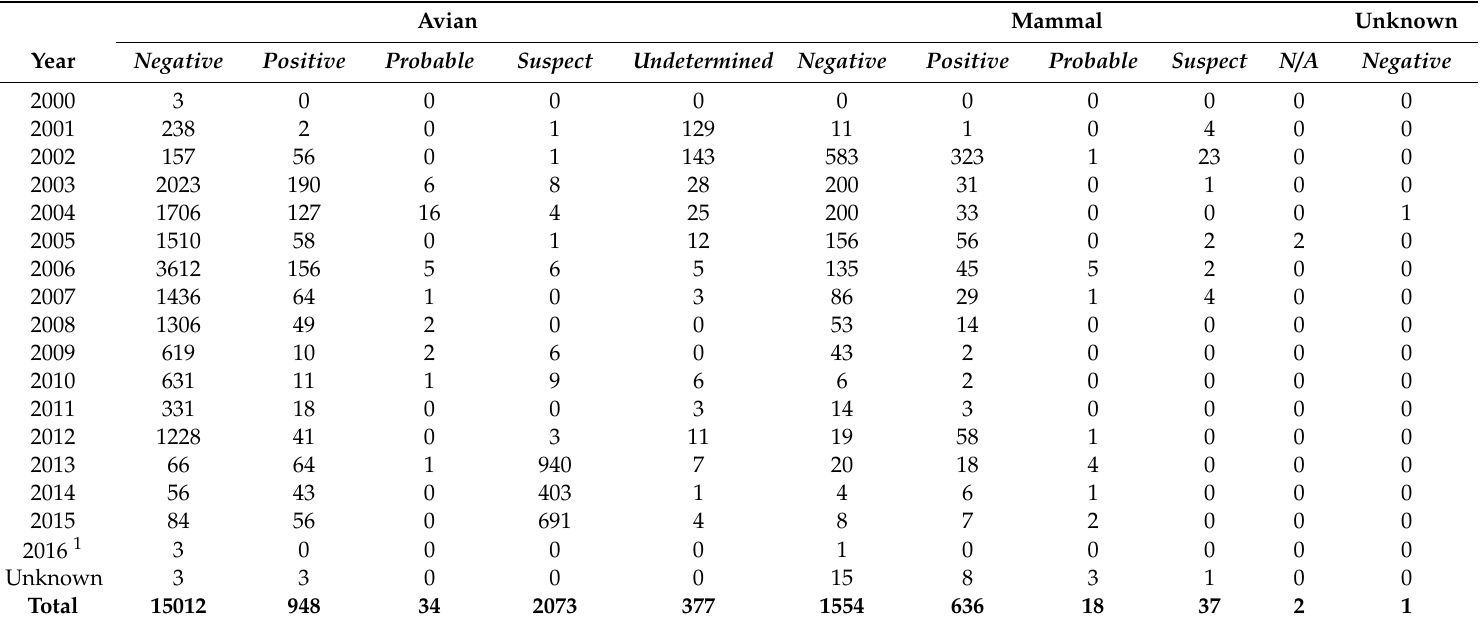
Table 1. Final case status for all specimens tested for WNV in Wisconsin by species type and year. The original case definitions used by the USGS, Wisconsin DHS, Wisconsin DNR, and Wisconsin WVDL are listed in the